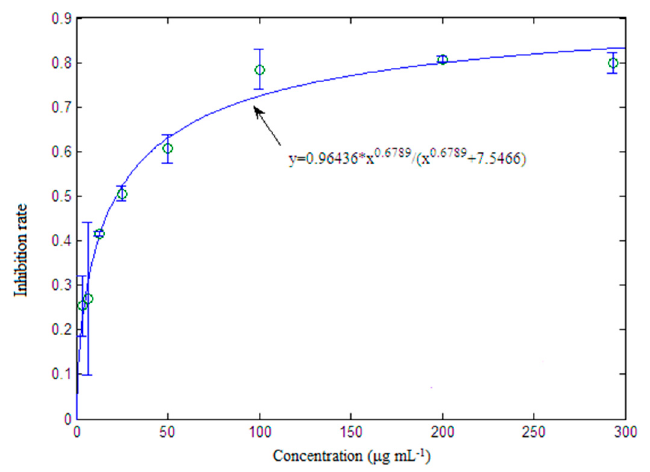
Figure 8. Concentration-response curve (CRC) of component 3 and its inhibition of RAW264.7 growth.